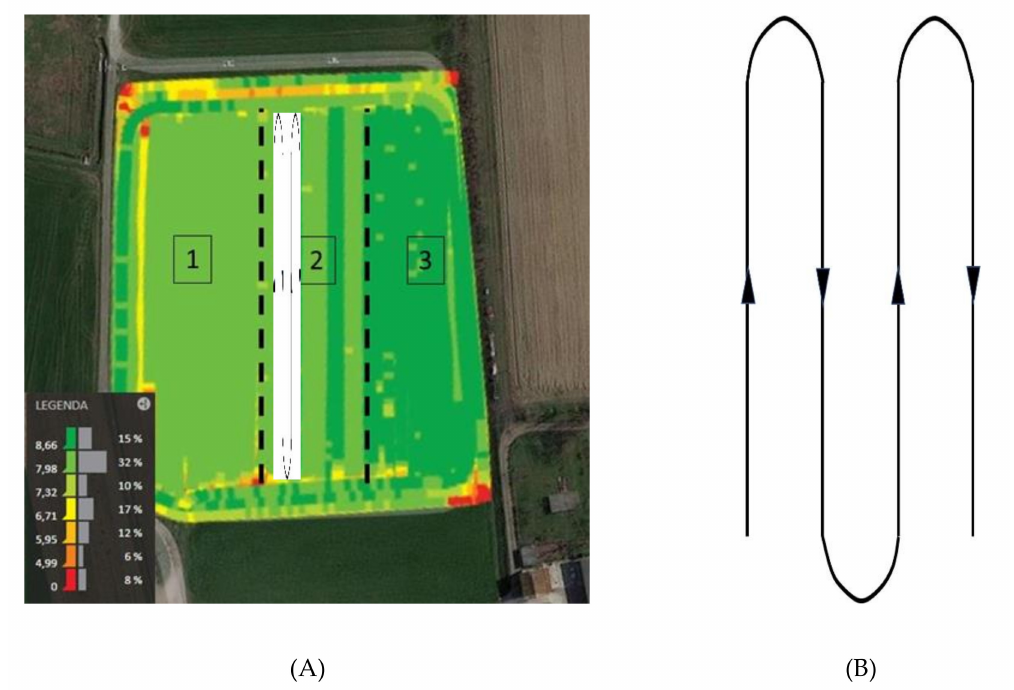
Figure 2. Test surface with a false-color map representing harrowing speeds in the three driving modes: (1) manual, (2) satellite-assisted, and (3) semi-automatic. Path of the measured parameters. ( A ) Test field ( B ) Path in which each acquisition was